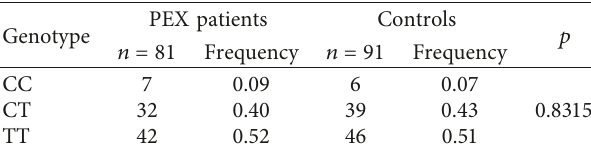
Table 2: Genotype frequencies of rs3087554 polymorphisms in Polish population.